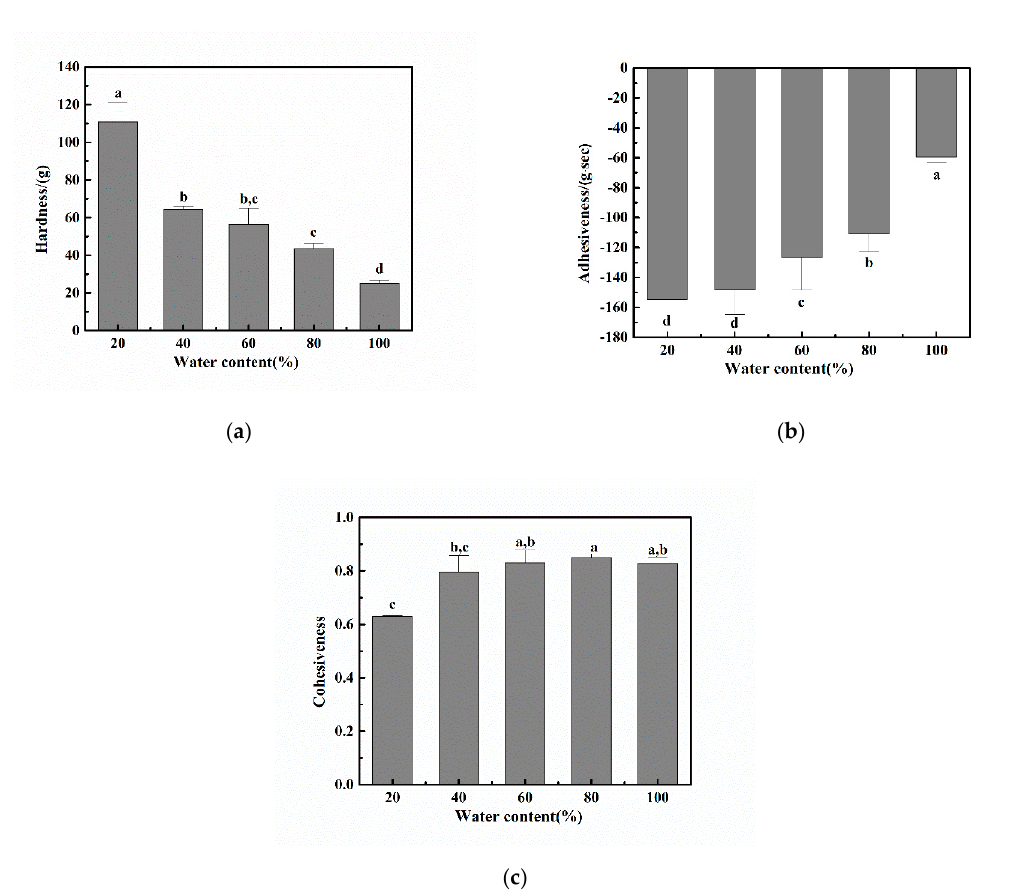
Figure 7. The mechanical properties of eutectogels with different water contents and hydrogel. ( a ) Hardness, ( b ) adhesiveness, and ( c ) cohesiveness ( n = 6). Bars indicate standard deviation (S.D.). Statistical differences withing each mechanical property are denoted by the small letters a–d, values presenting the same small letters in the figure mean that the samples had no significant differences between different water content.